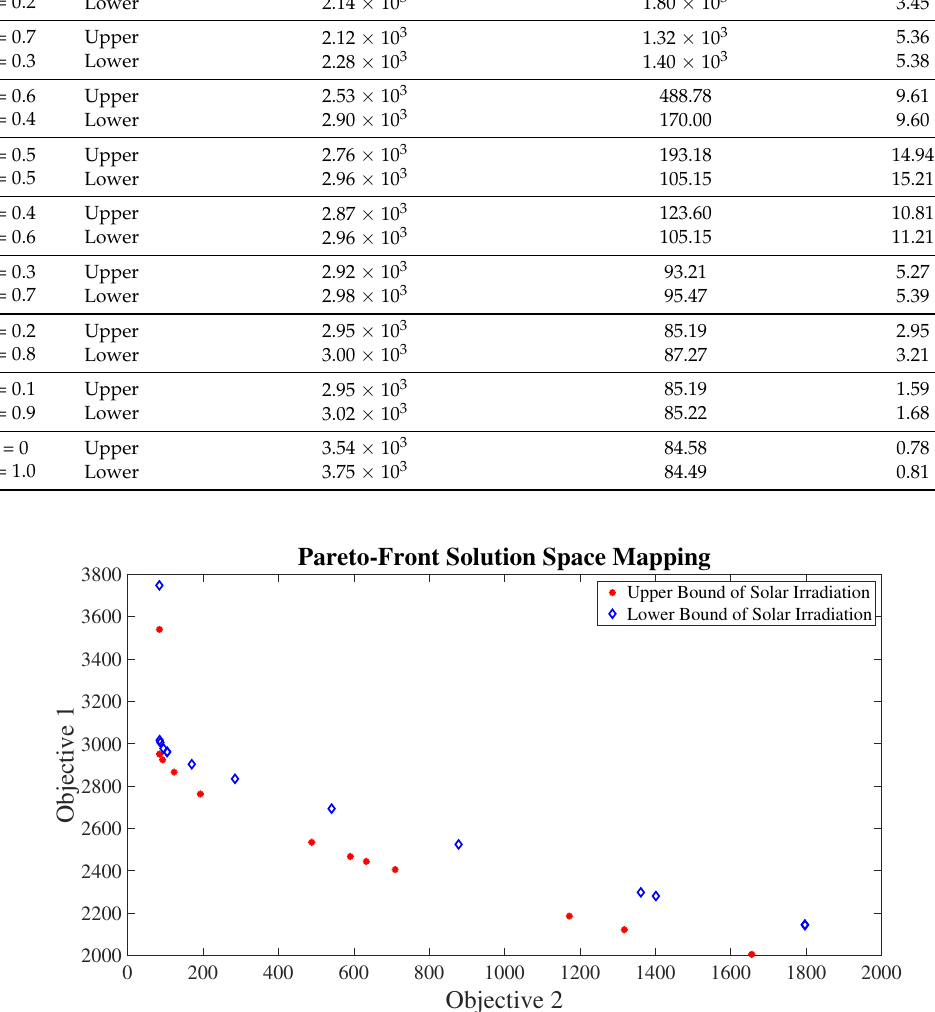
Figure 6. Pareto-front solution space with the interval solar irradiation